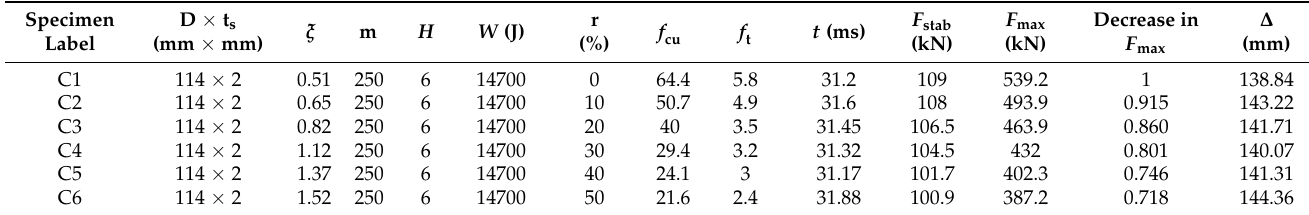
Table 4. Results of FE models with different rubber contents.